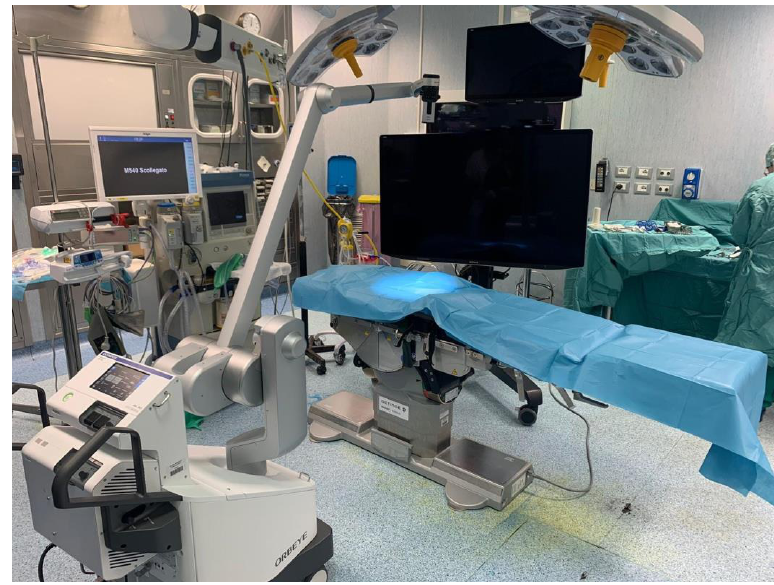
Figure 1. Orbeye exoscope 4K 3D and operating room setting.